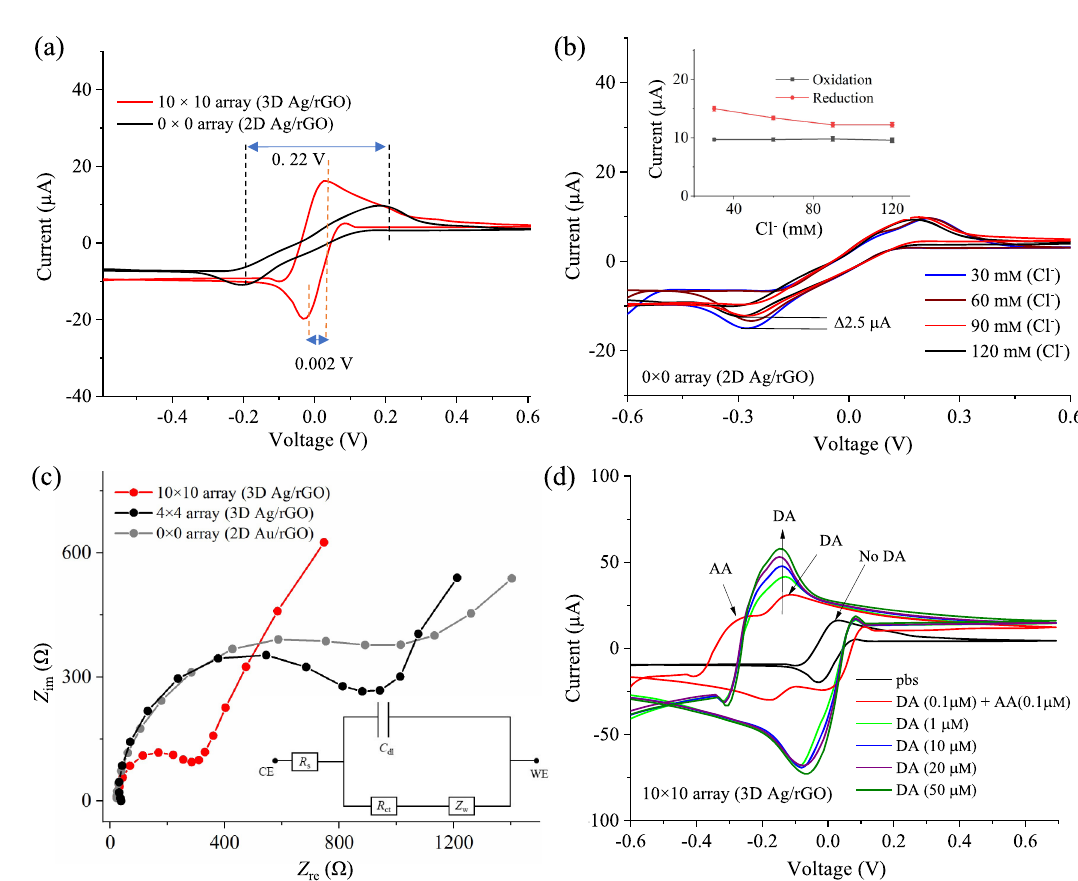
Fig. 3 Cyclic voltammetry results for different electrode architectures. a CV of 2D Ag/rGO (0 × 0 array) and 3D Ag/rGO (10 × 10 array) electrodes at a fi xed scan rate of 0.5 V/s. The CV experiment was carried out in the presence of pbs (50 m M , pH 7.4) added with equimolar concentration (1.0 m M ) of ferro/ferricyanide [Fe(CN) 6 ] 3 − /4 − mediator. b Effect of chloride (Cl − ) concentration using CV measurements for 2D Ag/rGO (0 × 0 array) electrode where the Cl − is varied from 30 to 120 m M . Inset of ( b ) depicts the variation of oxidation/reduction peak currents with Cl − concentrations. The concentration of ferro/ferricyanide was set to 1 m M at a fi xed scan rate of 0.5 V/s for this study. Oxidation current is found to be unchanged, but reduction potential showed a minute variation of current, ~2.0 µ A, at Cl − concentration of 30 – 90 m M after which it becomes saturated and stable. The graph in inset ( b ) corresponds to the median value of three repeated measurements ( n = 3). Error bars: median± SD. c The electrochemical impedance spectroscopy (EIS) responses of 2D Au/rGO (0 × 0 array), 3D Ag/rGO (4 × 4 array), and 3D Ag/rGO (10 × 10 array) for a voltage amplitude of 1 mV as a function of the frequency (1 – 10,000 Hz). Inset of ( c ) shows the equivalent electrical circuit diagram to evaluate the charge transfer resistance ( R ct ). The EIS/CV experiments were conducted in presence of pbs (50 m M , pH 7.4) containing an equimolar concentration of 1 m M [Fe(CN) 6 ] 3 − /4 − . d 3D sensor (10 × 10 array) electrode was used to detect dopamine concentration of 0.1 – 50 µ M and an investigation of cross-reactivity effect was performed in presence of ascorbic acid (AA) (0.1 µ M ) at a fi xed scan rate (0.5 V/s) and Cl - concentration (120 m M ). The results indicate that the current increases with an increase in dopamine concentration at a fi xed oxidation potential of − 0.14